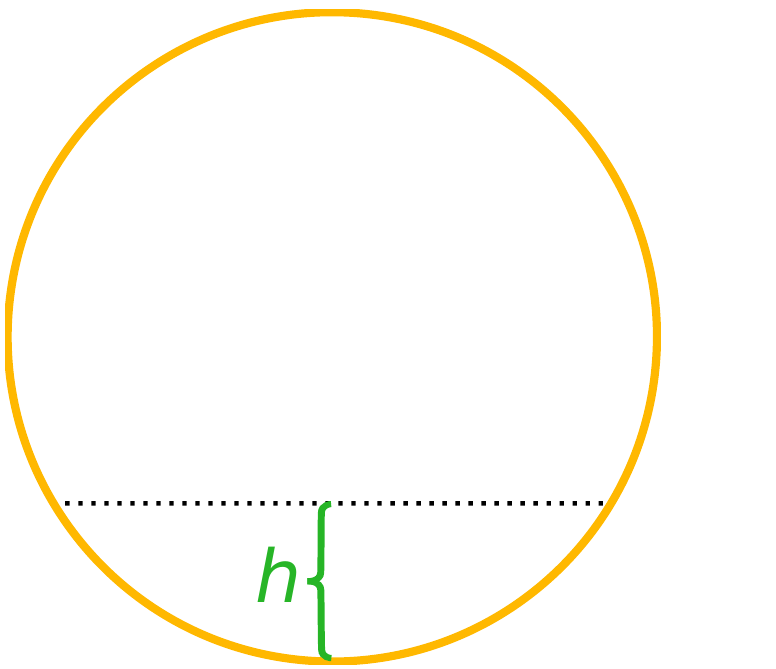
Figure 9. Cross-sectional view of the sewer pipe. The water level is measured by h which is the line orthogonal to the water line and the bottom of the pipe. Table 4. Details of the pollutants added to the laboratory water for the water level experiments. The amount of pollutants are found experimentally to maintain a certain level of cloudiness in the